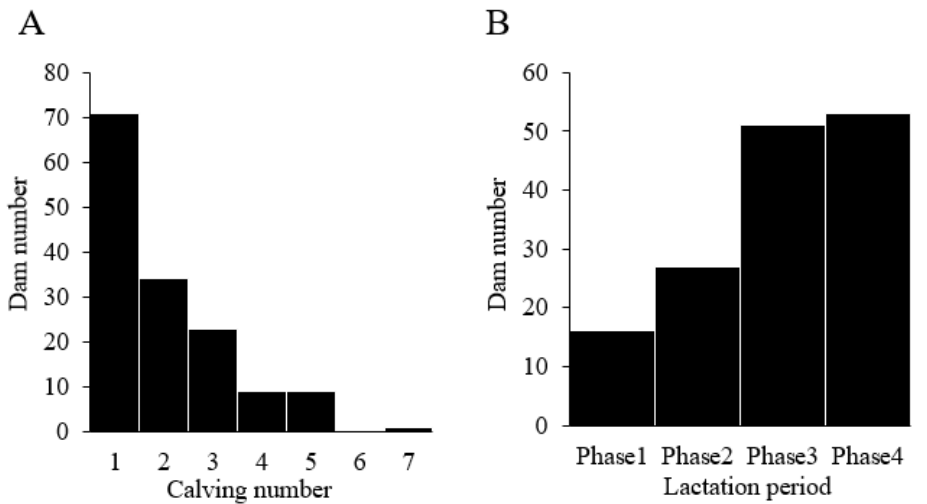
Figure 2. Distribution of dams by calving number and lactation period. ( A ) Distribution of dams by calving number. ( B ) Distribution of dams by lactation period. Dams were divided into four lactation phases: phase 1, 1–50 days (early lactation); phase 2, 51–110 days (peak lactation); phase 3, 111–210 days (mid-lactation); and phase 4, 211 days—dry period (late lactation).